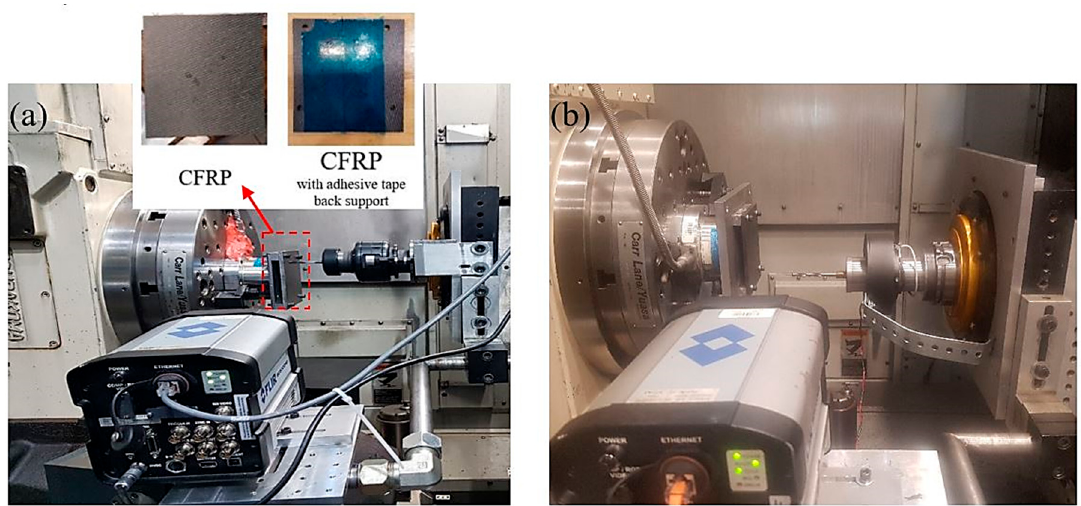
Figure 1. The developed experimental setup for ( a ) low-frequency vibration-assisted drilling (LF-VAD) and ( b ) high-frequency vibration-assisted drilling (HF-VAD).